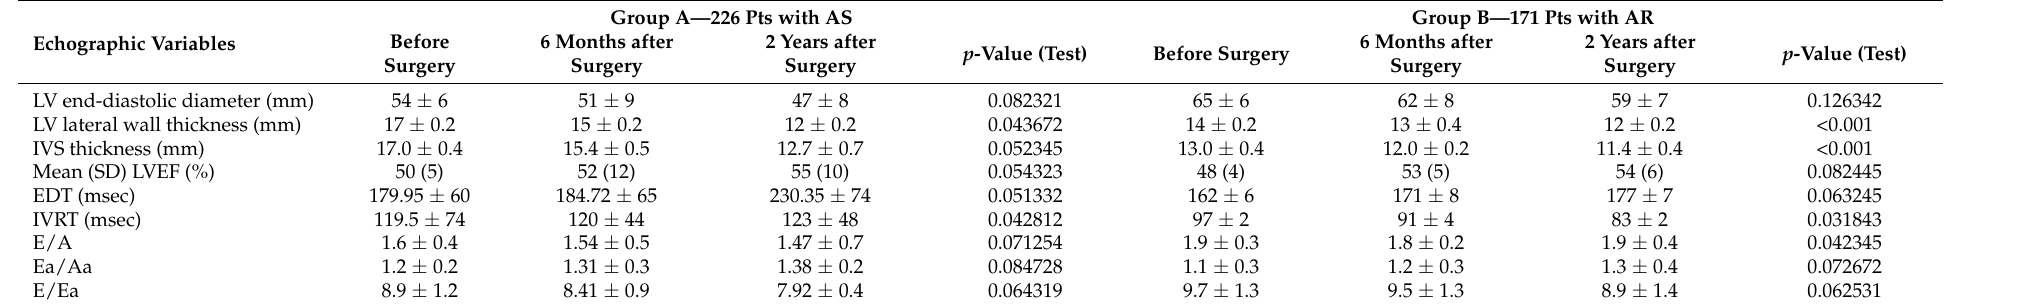
Table 2. Comparison of preoperative and postoperative echocardiographic